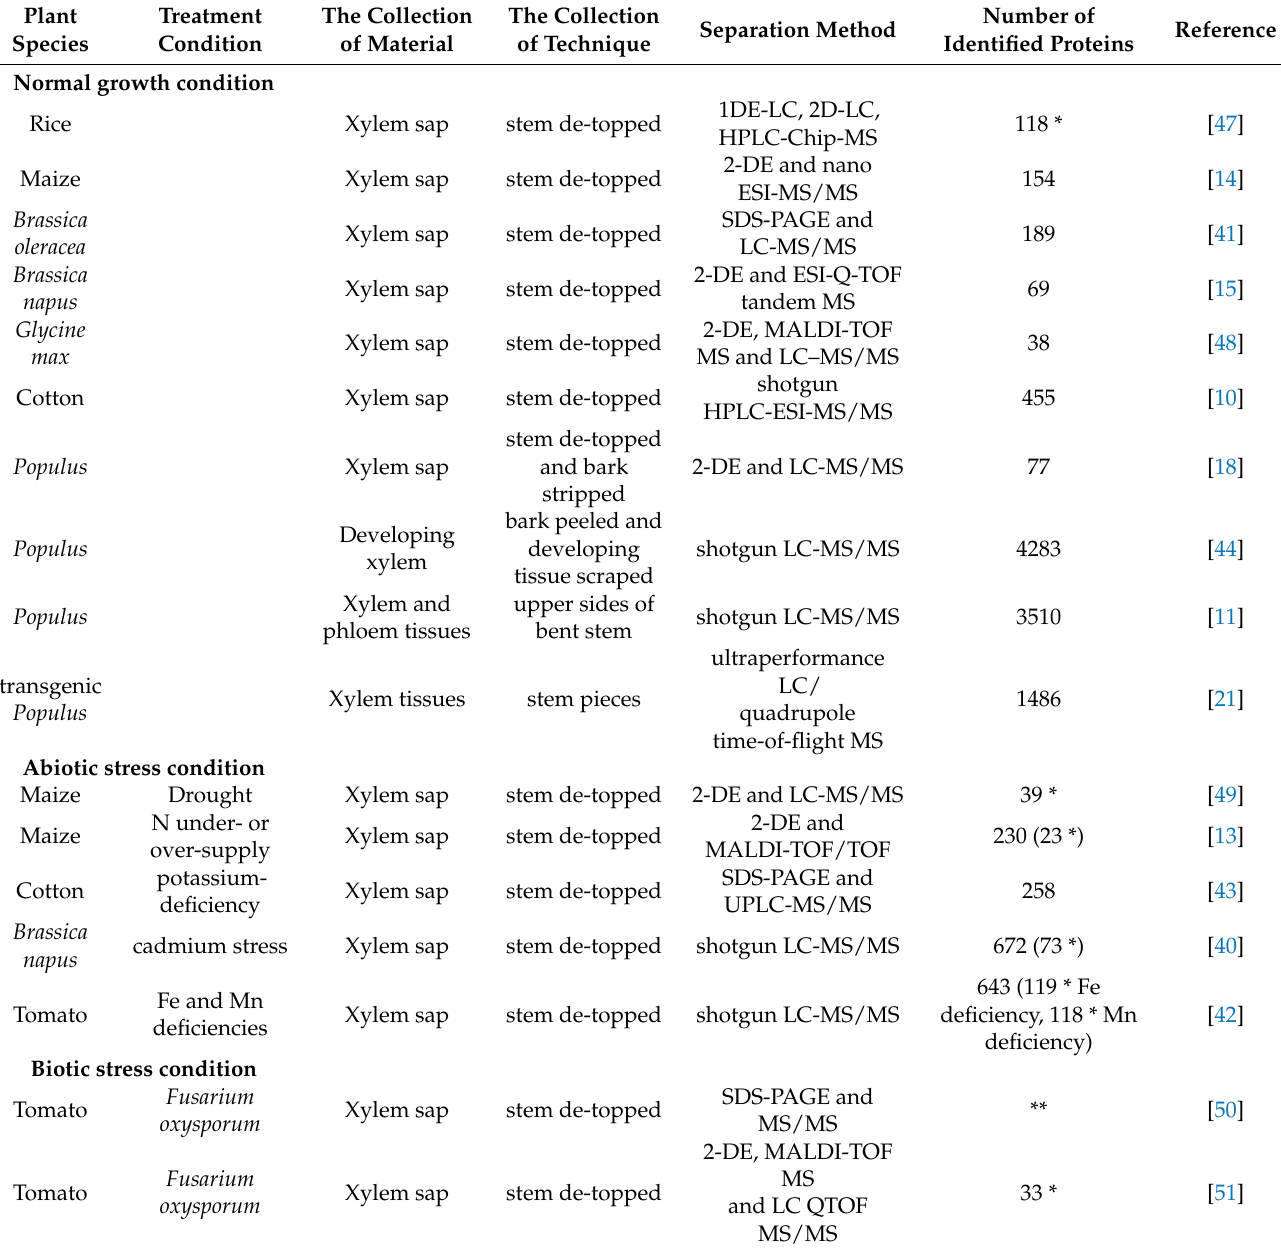
Table 1. Overview of the xylem